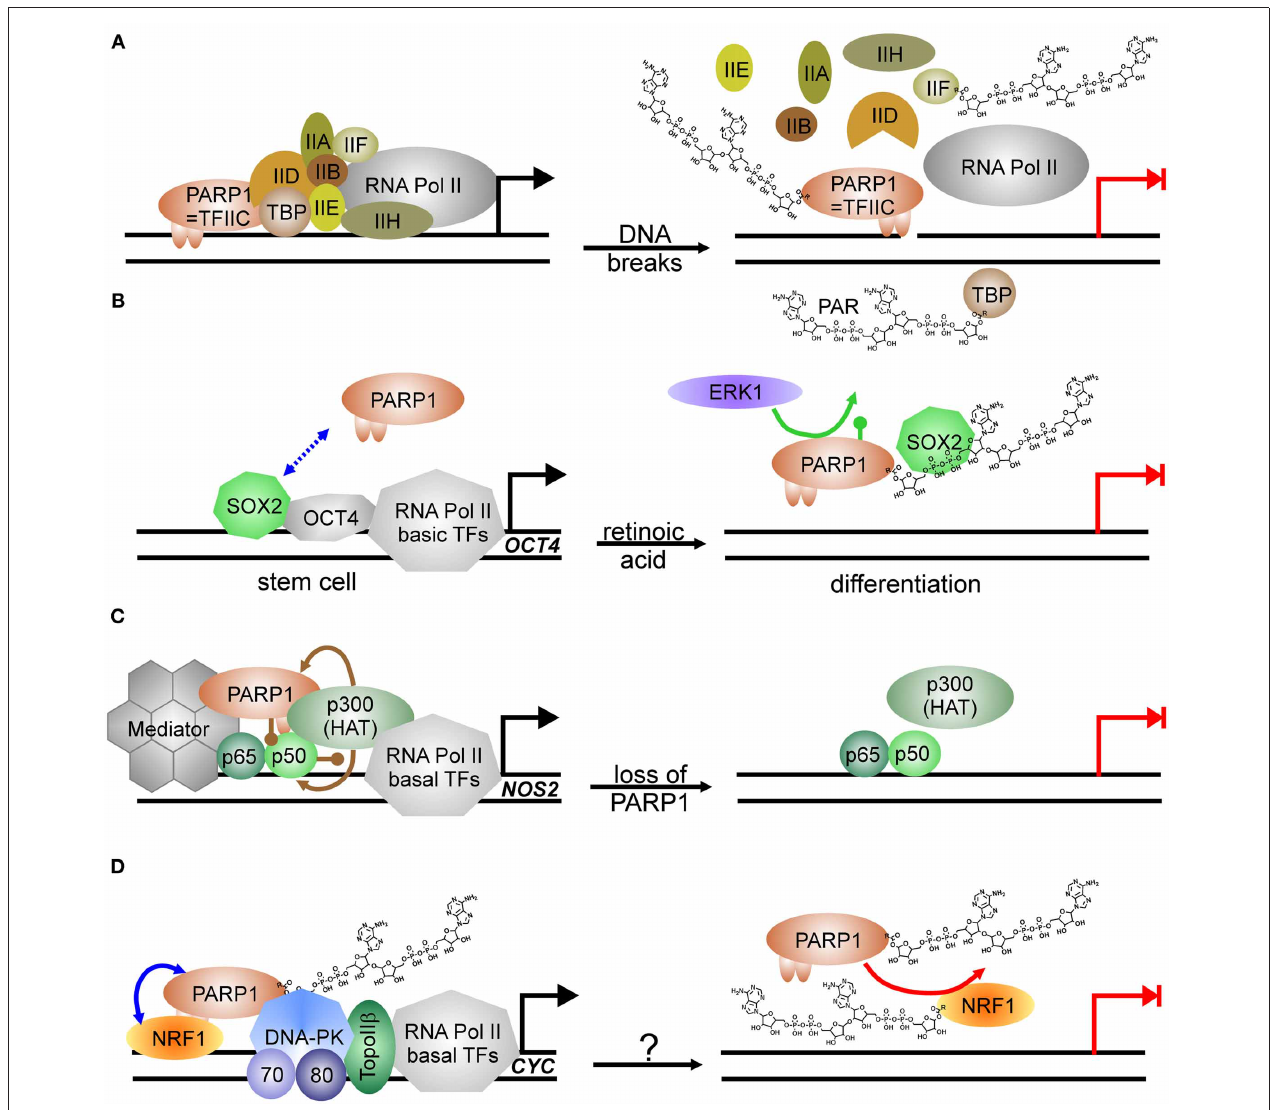
FIGURE 2 | PARP1-activity mediated suppression of transcription. (A) PARP1 as basal transcription factor TFIIC monitors DNA breaks in the vicinity of promoters. Transcription machinery is disassembled at pre-initiation complex formation due to modification of TBP (TATA-binding protein) and TFIIF with PAR after DNA damage induction. Transcription is blocked (switch from black arrow to blocked red arrow). (B) PARP1 in regulation of stem cell differentiation. SOX2 weakly interacts with PARP1 (dashed double-headed blue arrow). Phosphorylation (green lollypop) of PARP1 by kinase ERK1 leads to auto-modification of PARP1. SOX2 DNA-binding and dimerization with OCT4 is disrupted by interaction with PARylated PARP1. Transcription is abrogated (switch from black arrow to blocked red arrow). (C) Positive impact of PARP1 protein itself on transcription as co-activator of NF κ B. At the NOS2